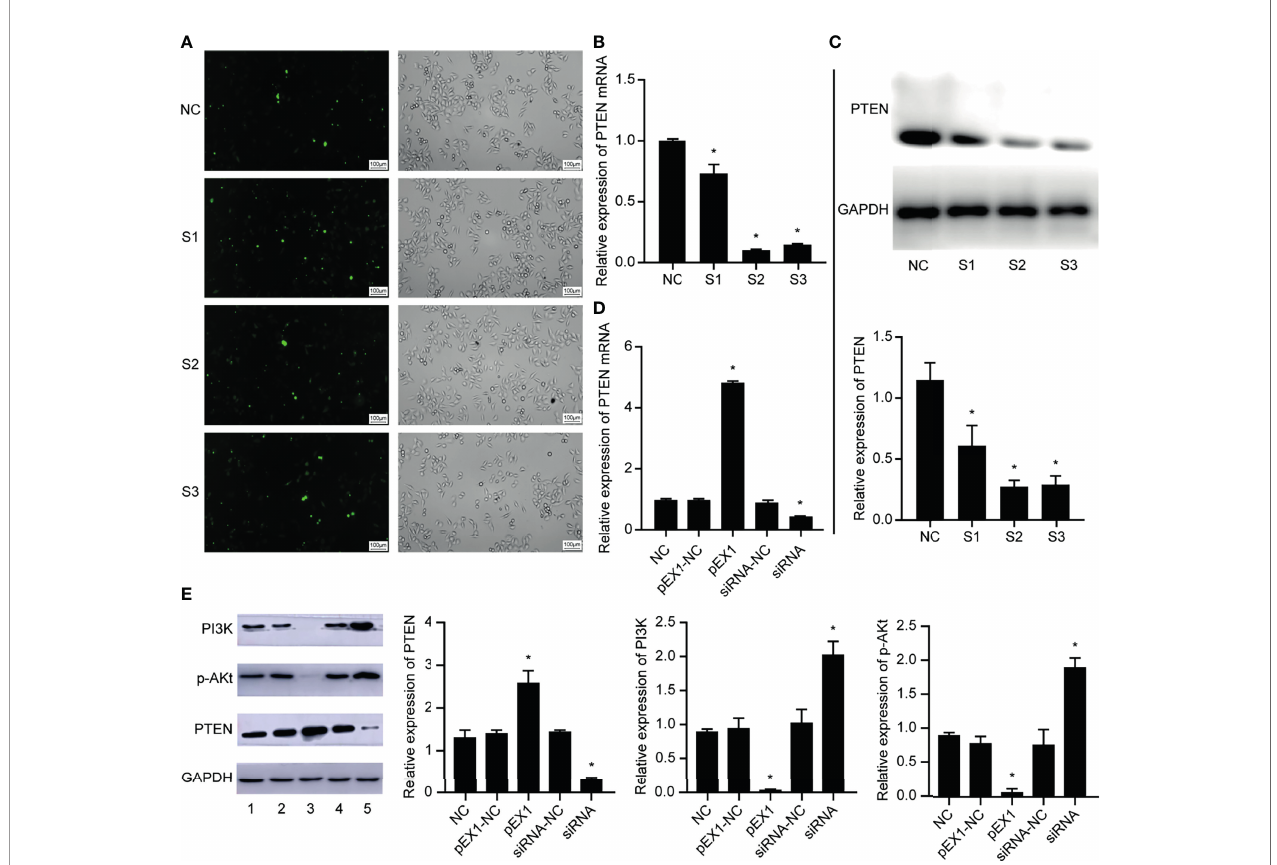
FIGURE 3 | Validation of EC9706 cell transfection experiment results. (A) Fluorescence microscope image of esophageal cancer cells transfected with fl uorescently- labeled siRNA (200×); (B) Relative expression of PTEN mRNA in each group of EC9706 cells transfected with siRNA; (C) Relative expression of PTEN in each group of esophageal cancer cells transfected with siRNA; (D) Relative expression of PTEN mRNA in EC9706 cells transfected with siRNA and pEX1 (siRNA group: S2 sequence); (E) Relative expression of PTEN/PI3K/p-AKT in EC9706 cells transfected with siRNA and pEX1 (1: NC group; 2: pEX1-NC group; 3: pEX1 group; 4: siRNA-NC group; 5: siRNA group) (siRNA group: S2 sequence). *Compared with NC group, p <